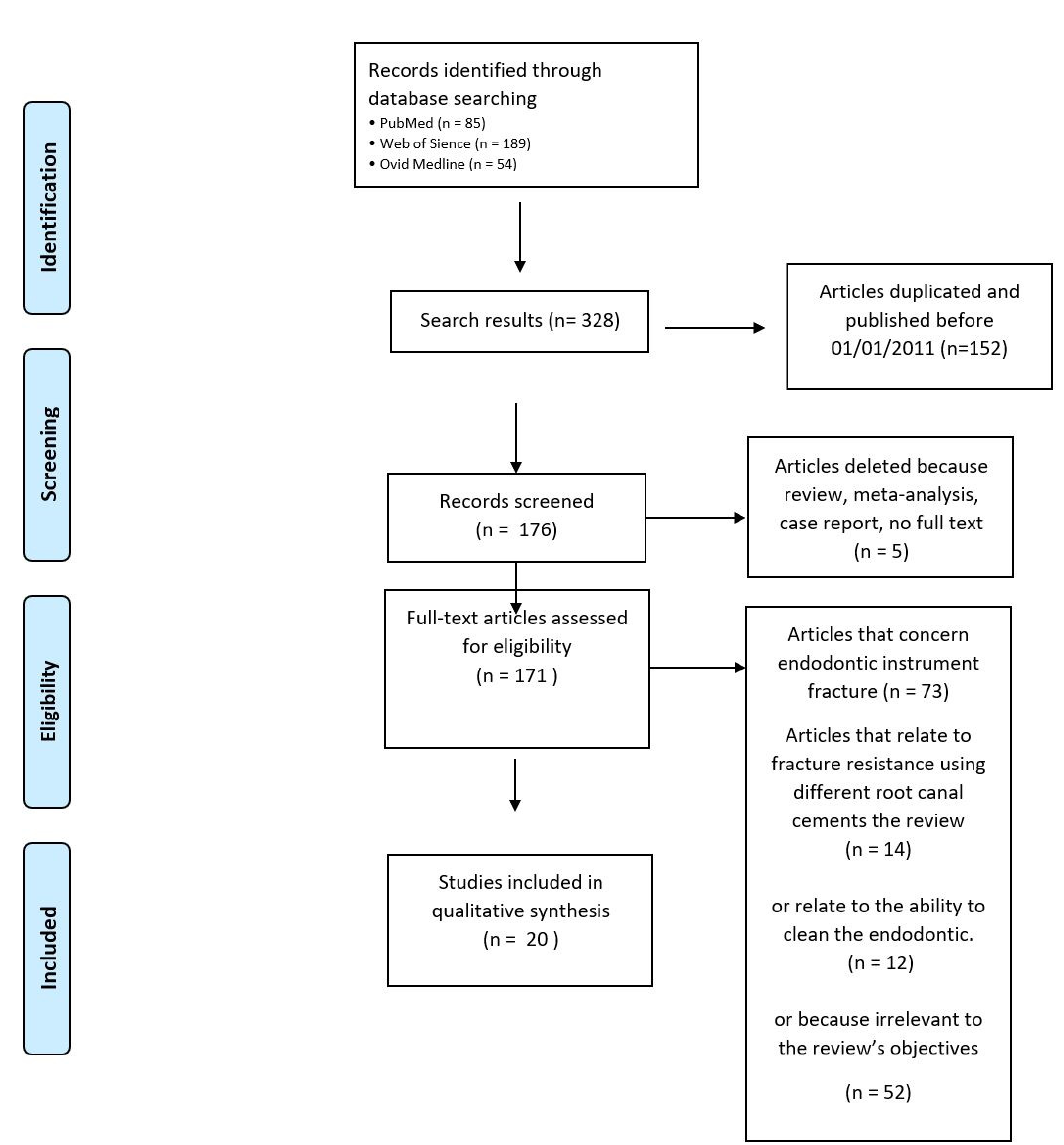
Figure 1. PRISMA flow chart.